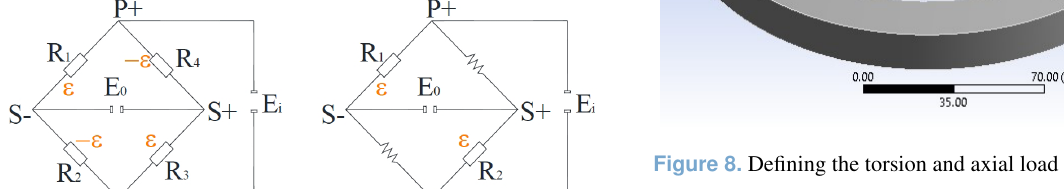
Figure 7. Half and complete Wheatstone bridges’ strain gauge con- nections.